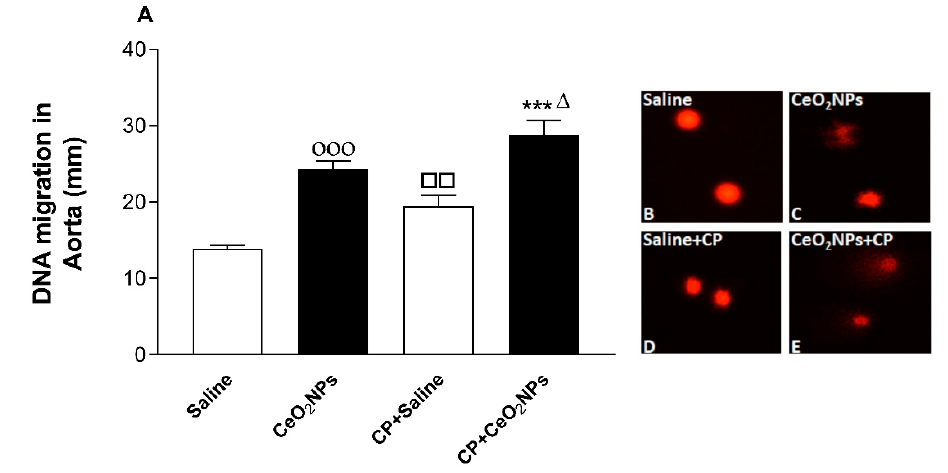
Figure 8. DNA migration (mm) in the aortic tissues evaluated by Comet assay in rats intratracheally instilled with either saline (control, n = 5) or cerium oxide nanoparticles (CeO 2 NPs, n = 5) with ( n = 5) or without ( n = 5) cisplatin (CP) administration. *** P < 0.001 compared with CP + saline-treated group. Δ P < 0.05 compared with CeO 2 NPs-treated group. □□ P < 0.01 compared with saline-treated group. οοο P < 0.001 compared with saline-treated group. Data are mean ± SEM. Images illustrating the quantification of DNA migration by the Comet assay under alkaline conditions in saline, CeO 2 NPs with or without CP administration.